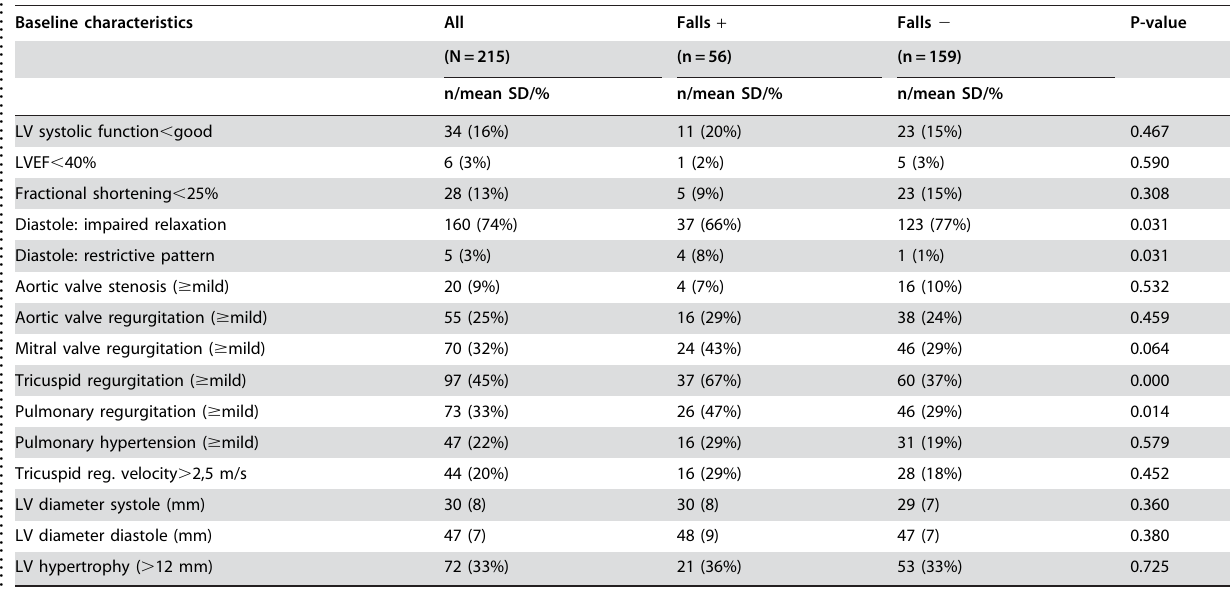
Table 2. Prevalence of Cardiac Abnormalities on Echo(Doppler)cardiography. .. ... .... ... ... .... ... ... .... ... ... .... ... ... .... ... ... .... ... ... .... ... ... .... ... ... .... ... ... .... ... ... .... ... ... .... ... ... .... ... ... .... ... ... . Baseline characteristics